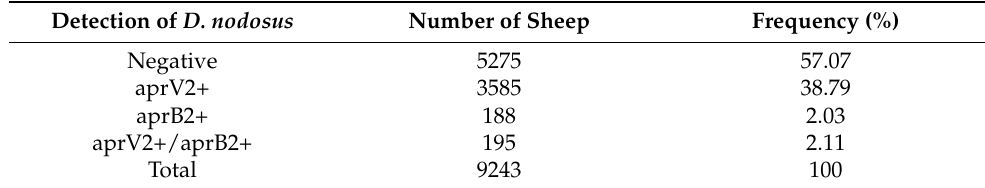
Table 5. Numbers and frequencies of sheep tested positive for virulent, benign D. nodosus , both virulotypes and negative for D. nodosus.